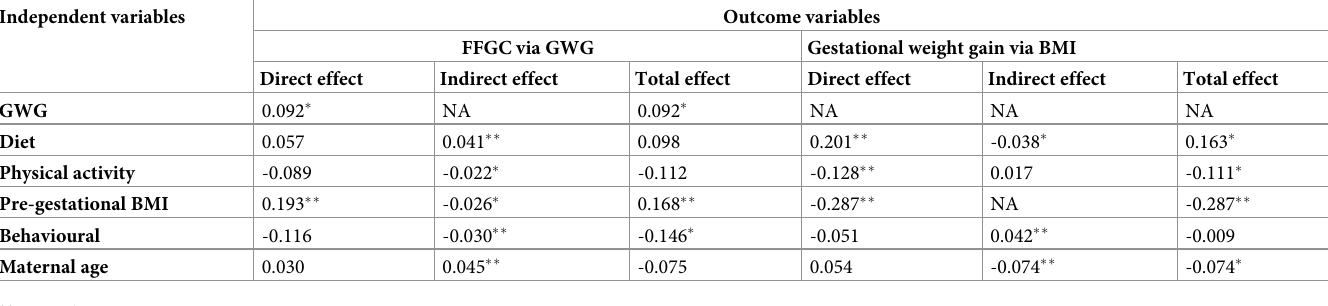
Table 3. Maximum likelihood ratio bootstrapped estimates of direct, indirect and total effects under Model